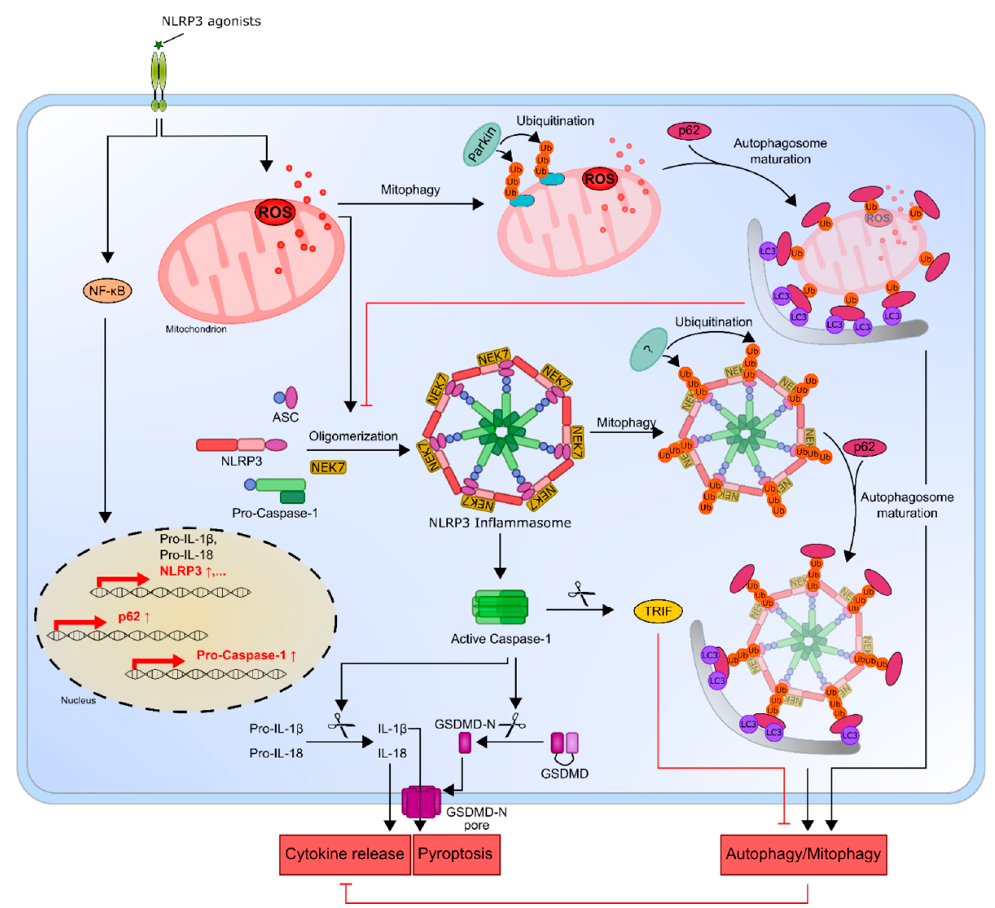
Figure 3. The NLRP3 inflammasome and its connection to mitophagy/autophagy. NLRP3 agonists promote the NF- κ B- induced expression of inflammasome components but, also, the expression of p62, which negatively regulates caspase-1 activation by the elimination of mitochondria via mitophagy. NLRP3 activation can also lead to the ubiquitination of NLRP3 inflammasome components and destruction in the autophagosome, thereby limiting IL-1 β secretion. In addition, NLRP3 inflammasome activation is able to attenuate autophagy via the caspase-1-mediated cleavage of TRIF, which enhances inflammasome activation. ↓ = Activation; ⊥ = Inhibition. NLRP3, NOD-like receptor protein 3; ASC, apoptosis-associated speck-like protein; NEK7, NIMA-related kinase 7; GSDMD, Gasdermin-D; GSDMD-N, GSDMD amino-terminal cell death domain; NF- κ B, nuclear factor- κ B; ROS, reactive oxygen species; Ub, ubiquitin; Parkin, E3 ubiquitin protein ligase; LC3, microtubule-associated proteins 1A/1B light chain 3B and TRIF, TIR-domain-containing adapter-inducing interferon- β